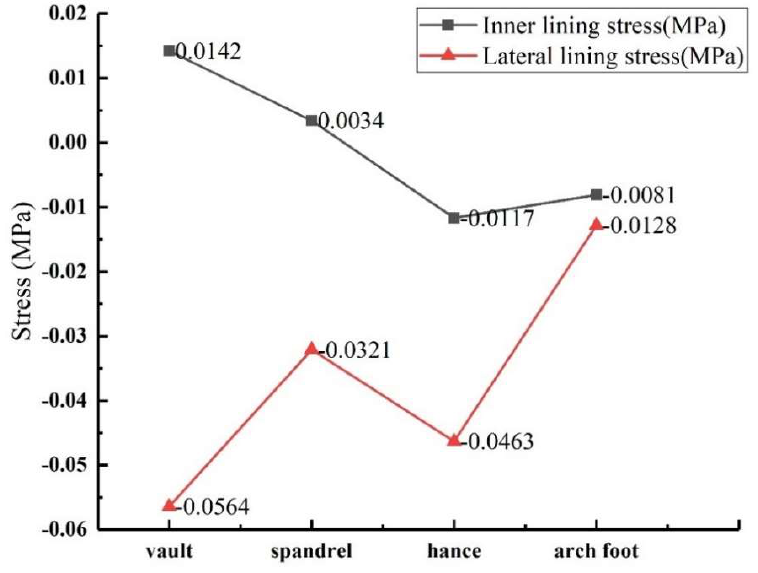
Figure 16. Lining stress variation law with void location.